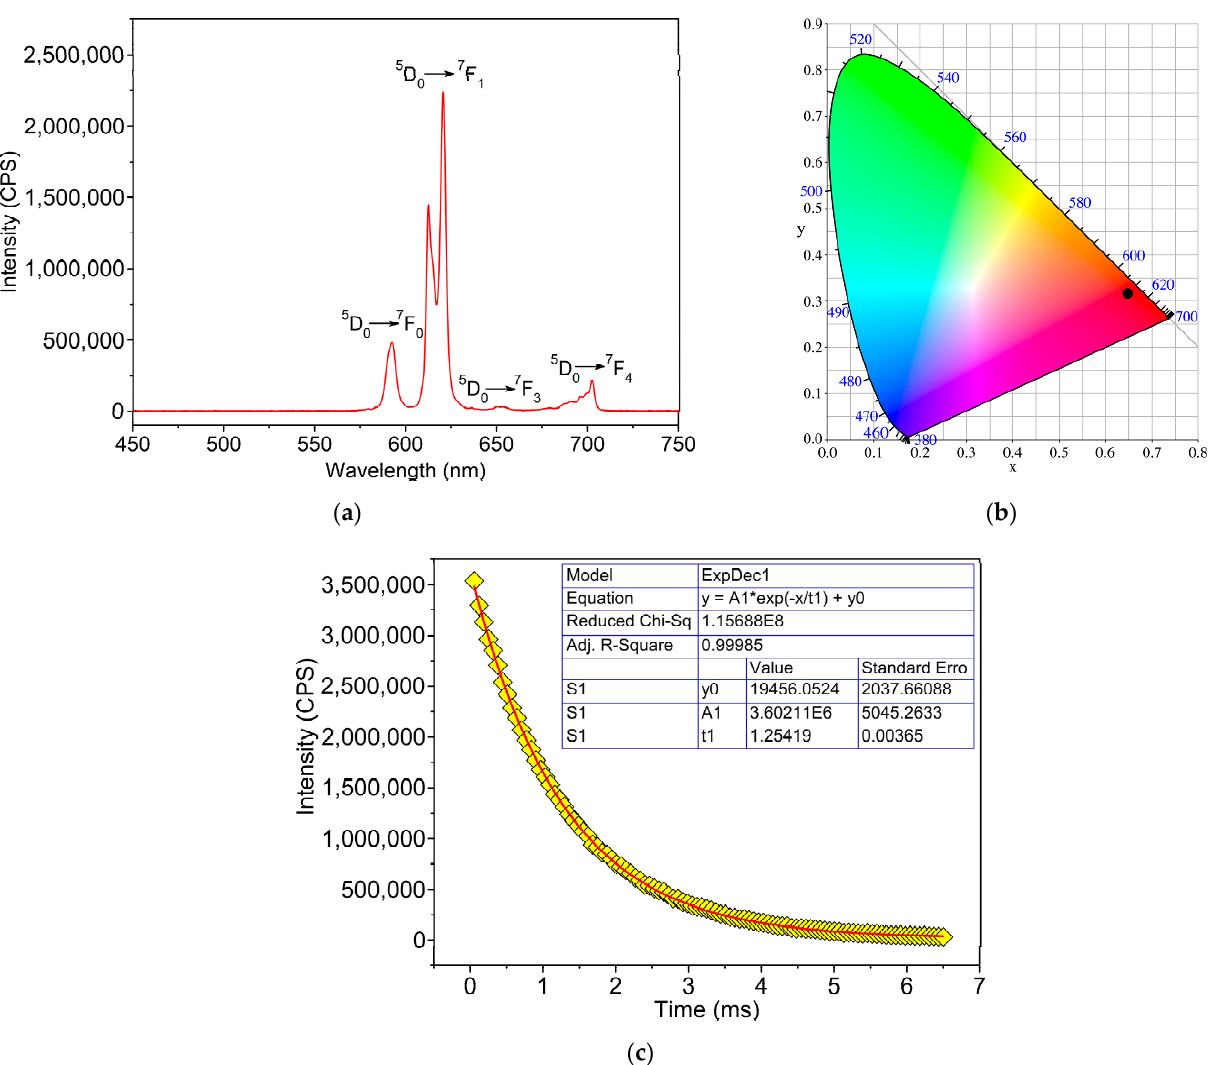
Figure 6. ( a ) Emission spectra and colorimetric coordinates (insert), ( b ) the 1931 CIE chromaticity diagram, and ( c ) emission intensity decay for 2 ( λ ex = 297 nm).